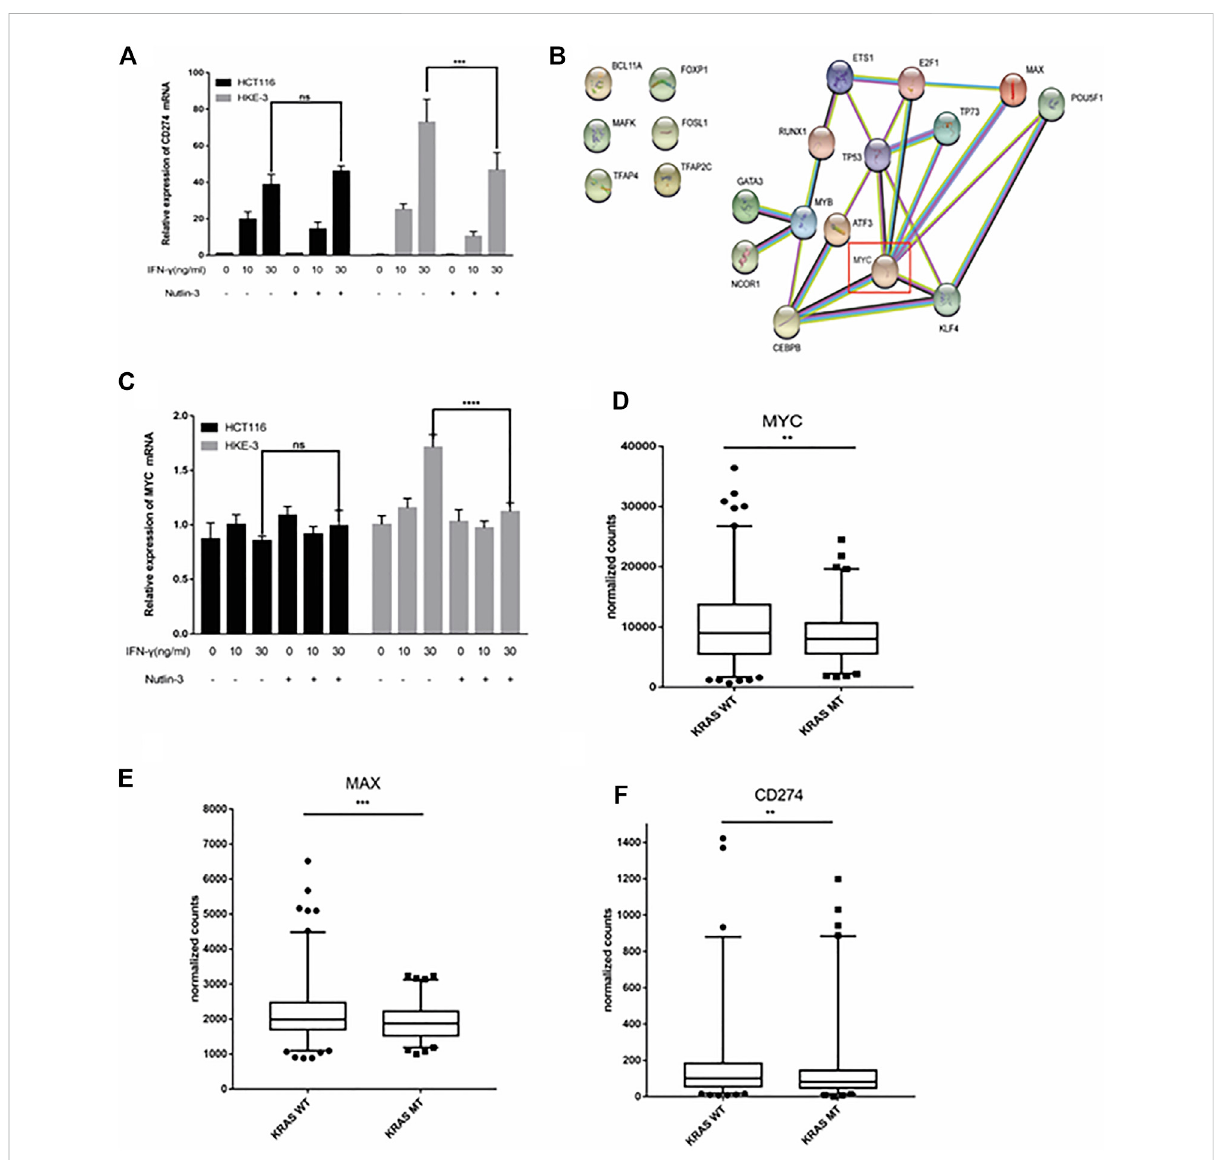
TP53 showed different effects on IFN- γ -induced CD274 expression. (A) After treatment with IFN- γ and nutlin-3, cells were collected for detection of CD274 (PD-L1) mRNA expression. (B) STRING protein – protein interaction analysis, highlighting the interaction between TP53 and the above selected 19 transcription factors. (C) After treatment with IFN- γ and nutlin-3, cells were collected for detection of MYC mRNA expression. (D – F) Analysis of CD274, MYC, and MAX gene expression in colon tumor samples with different KRAS mutant statuses using TCGA data. ** p < 0.01, *** p < 0.001, and **** p <